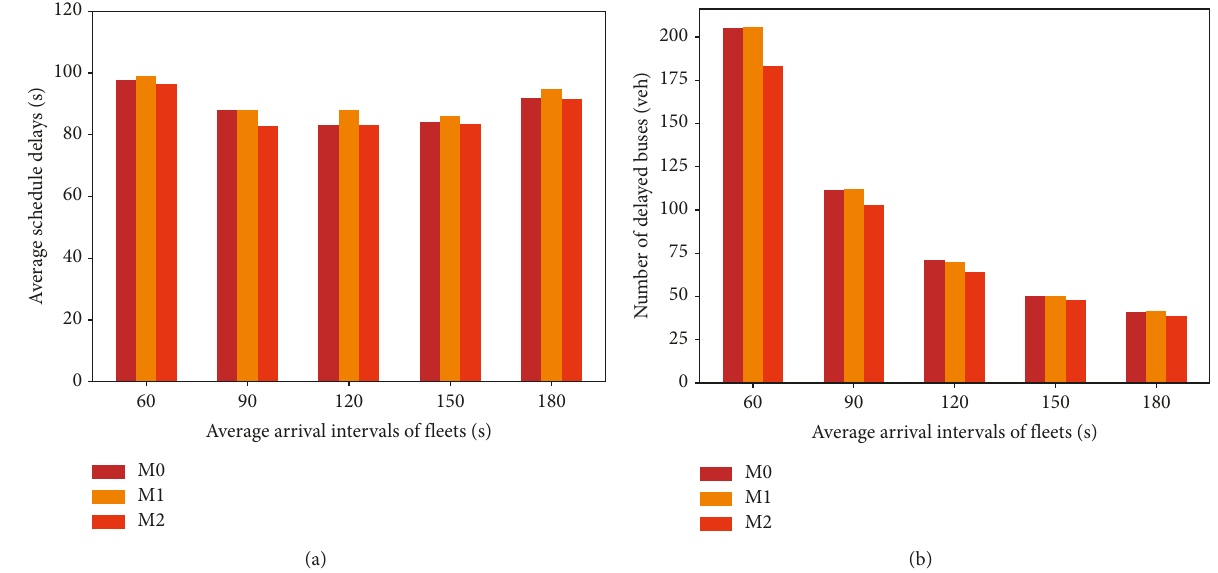
Figure 9: Bus punctuality: (a) average schedule delays and (b) numbers of delayed